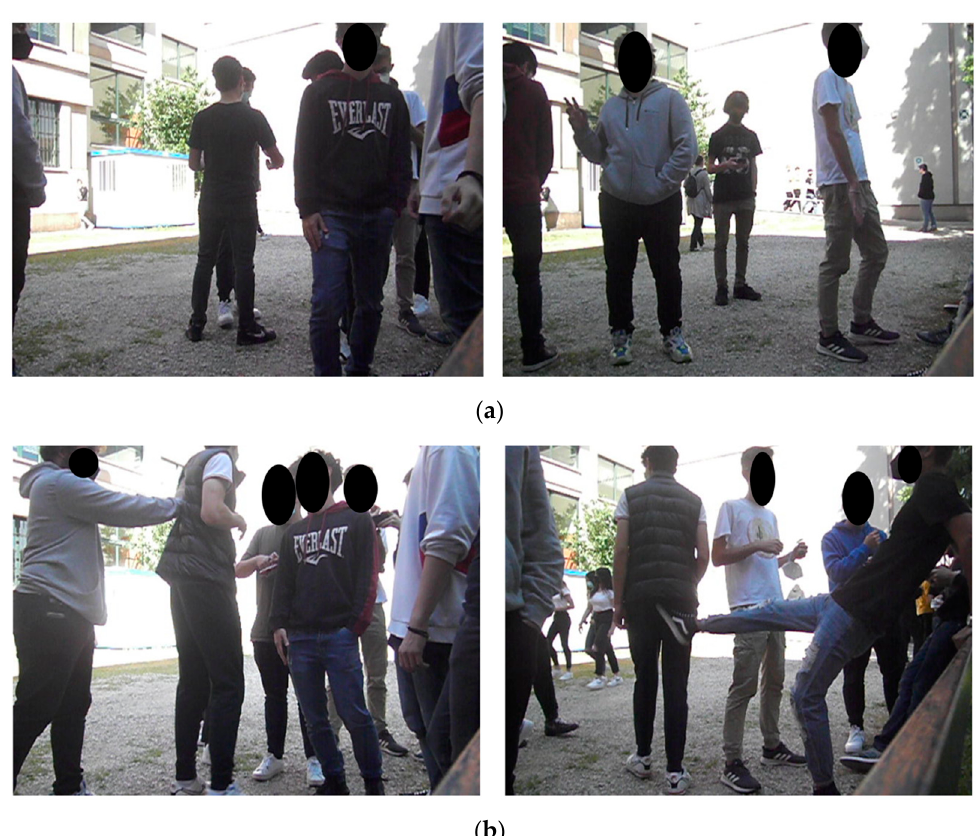
Figure 4. ( a , b ) Daily School Break dataset: ( a ) non-violence and ( b ) violence sequence